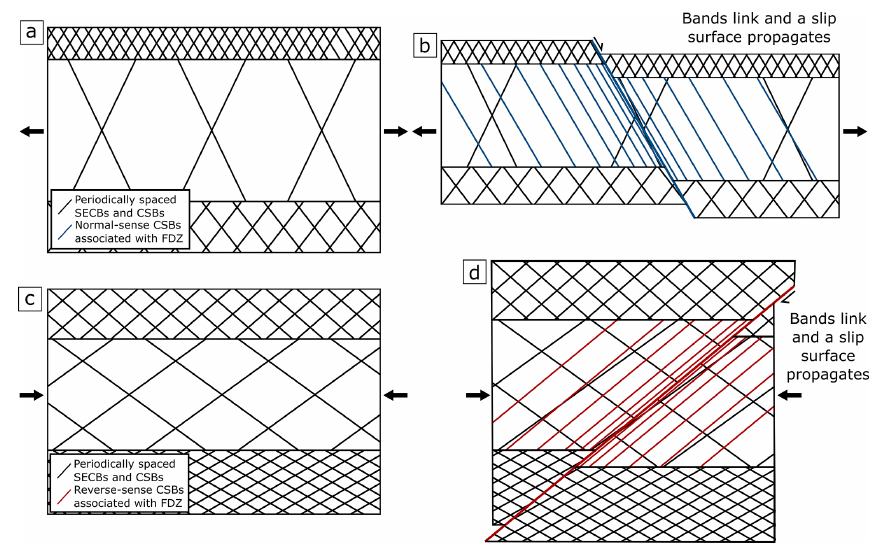
Figure 17. A schematic to show the evolution of spatial distributions in normal-faulting (a, b) and reverse-faulting (c, d) tectonic regimes. Initially, bands with an equal spacing form. Band spacing is theorised to be proportional to the layer thickness, as is observed with joints (Pollard and Aydin, 1988; Gross, 1993). Eventually, bands link across layers and a fault propagates (Aydin and Johnson, 1983). The fault movement causes the local stress field to be perturbed resulting in new band formation with orientations and kinematics matching those of the new local stress